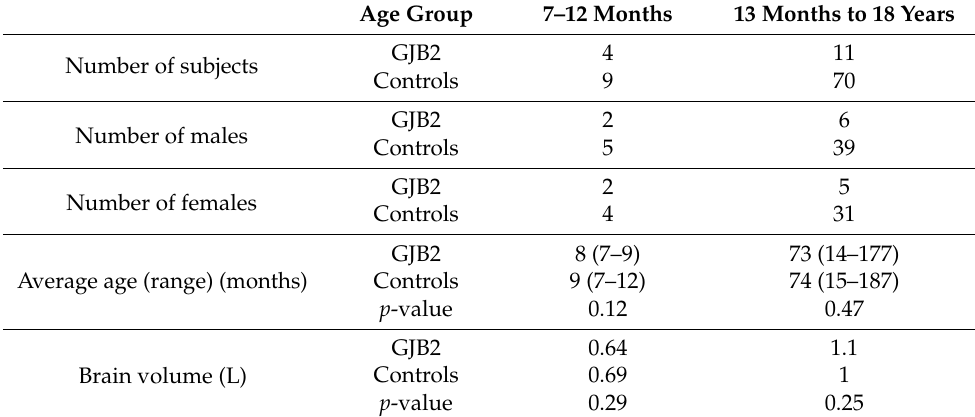
Legend: Overview of age and gender in different age groups for patients and